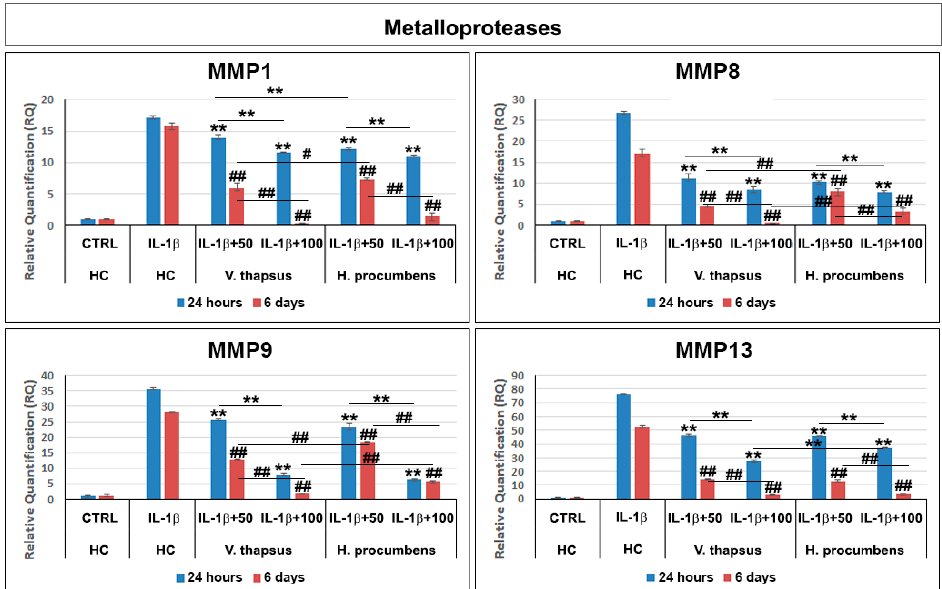
Figure 5. Effects of V. thapsus and H. procumbens treatment on IL-1 β -induced expression levels of inflammatory cytokines and enzymes. Data are represented as the means ± SD of three independent experiments. ANOVA test p -values were reported ( p < 0.0001) and (**, ## p < 0.01 and *, # p < 0.05) indicate significant differences between the two groups, as reported by the Holm post hoc test.